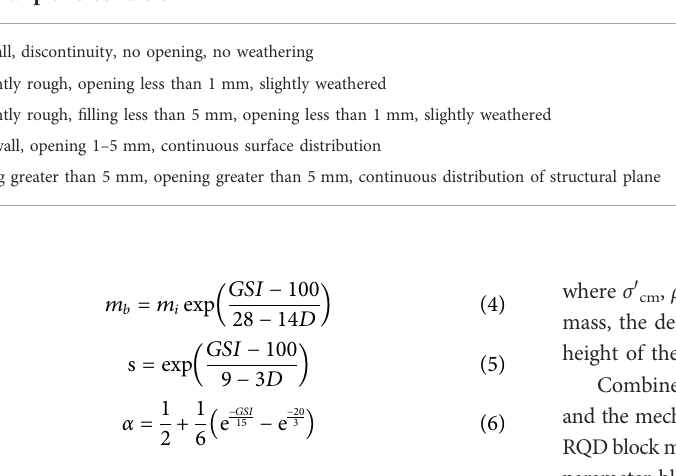
TABLE 1 De fi nition of JCond 89 after bieniawski (1989) and (Singh and Goel, 2011). Structural plane